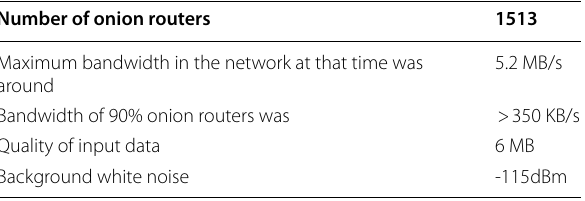
Influence of Low Internet Fraud Governance